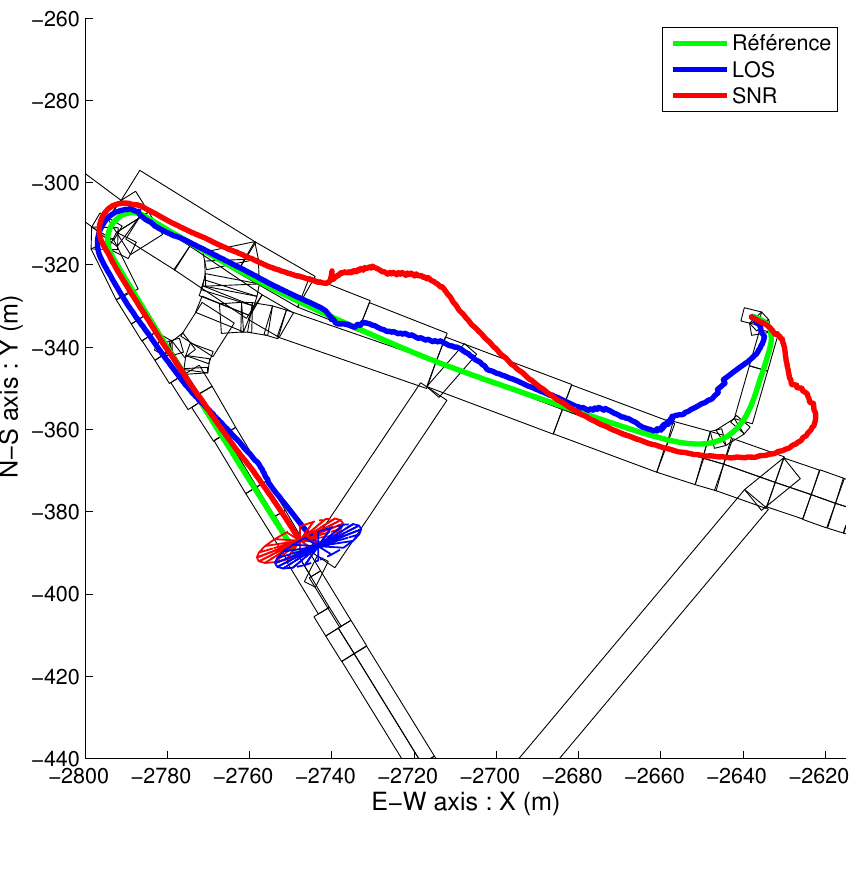
2D overview of ”free” solutions (without map-aiding) for both strategies. Simplified